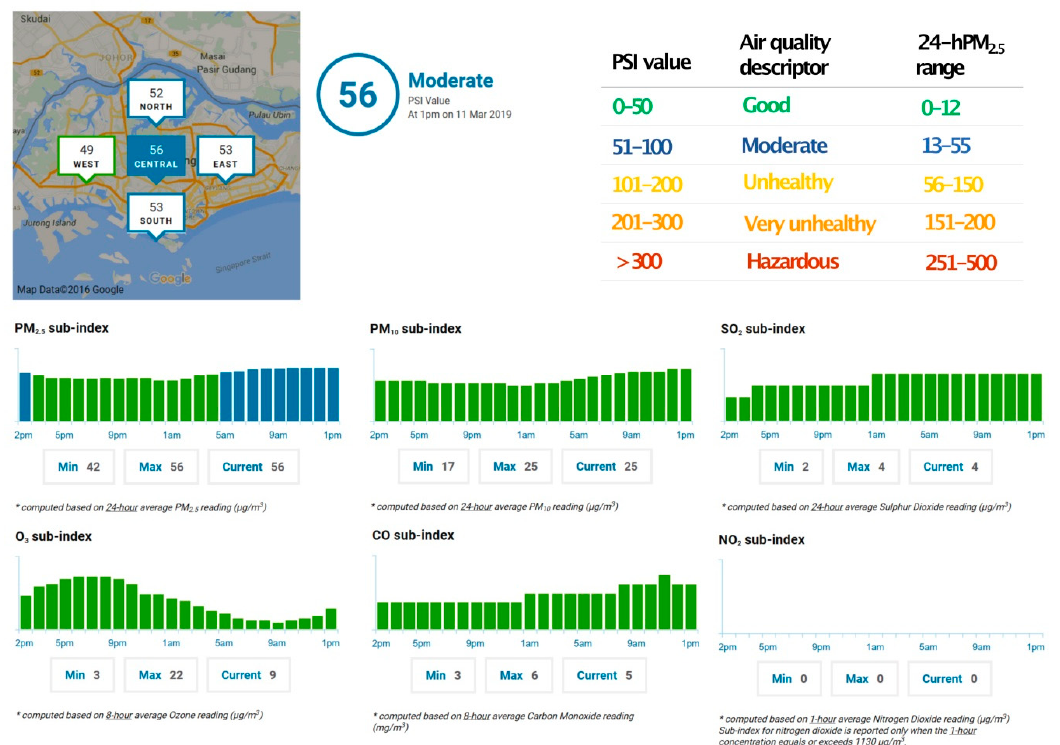
Figure 10. Air quality information provided hourly by Singapore’s authorities [126]. The screenshot of the map shows the pollutant standard index (PSI) values for each of the five sections in which the island is divided for air quality purposes; the corresponding sub-indexes for each monitored pollutant show that PM 2.5 triggered moderate air quality conditions on that particular day and hour. The breakpoints for PM 2.5 that are used to define the PSI category are included for reference.